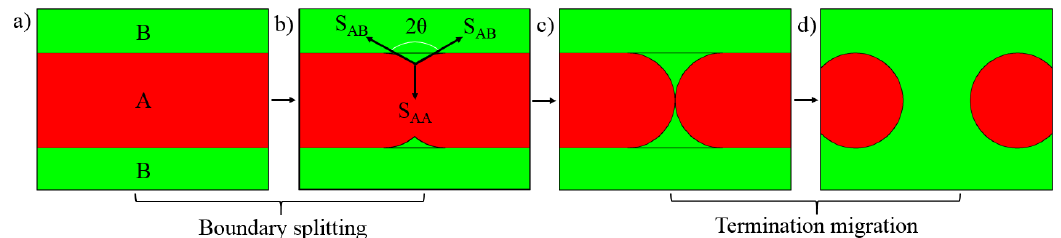
Figure 8. Schematic diagram of α lamellae decomposition: ( a ), ( b ) boundary splitting mechanism and ( c ), ( d ) termination migration mechanism.